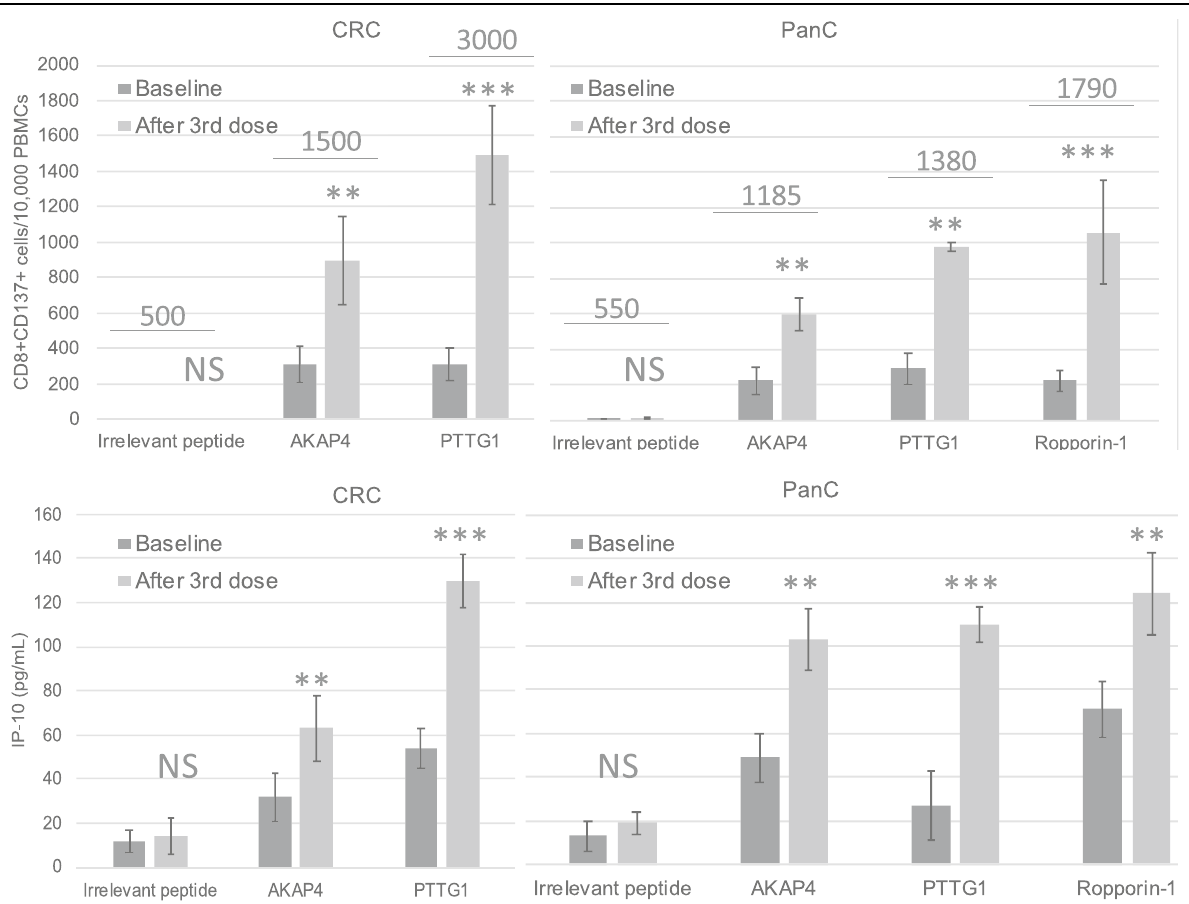
Fig. 5 TAPA-specific T-cell response. The TAPA-specific activation of PBMCs-derived T-cells was measured by flow-cytometry by evaluating the number of CD8 + CD137+ events per 10,000 PBMCs exposed to the indicated peptides. Results show average (+/ − 95% C.I.) out of triplicate measurements, obtained from PBMCs taken at baseline (before the first vaccine dose), and after the third dose of vaccine. For each peptide stimulus, a two-way t test (alpha = 0.05) was performed to compare the mean CD8 + CD137+ numbers or the mean IP-10 levels between baseline and post-third vaccine (**, p < 0.01; ***, p < 0.001; NS, not significant). The horizontal lines in the upper panels indicate the number of total CD8+ event /10,000 cells before the stimulation with the peptides in vitro (regardless of CD137